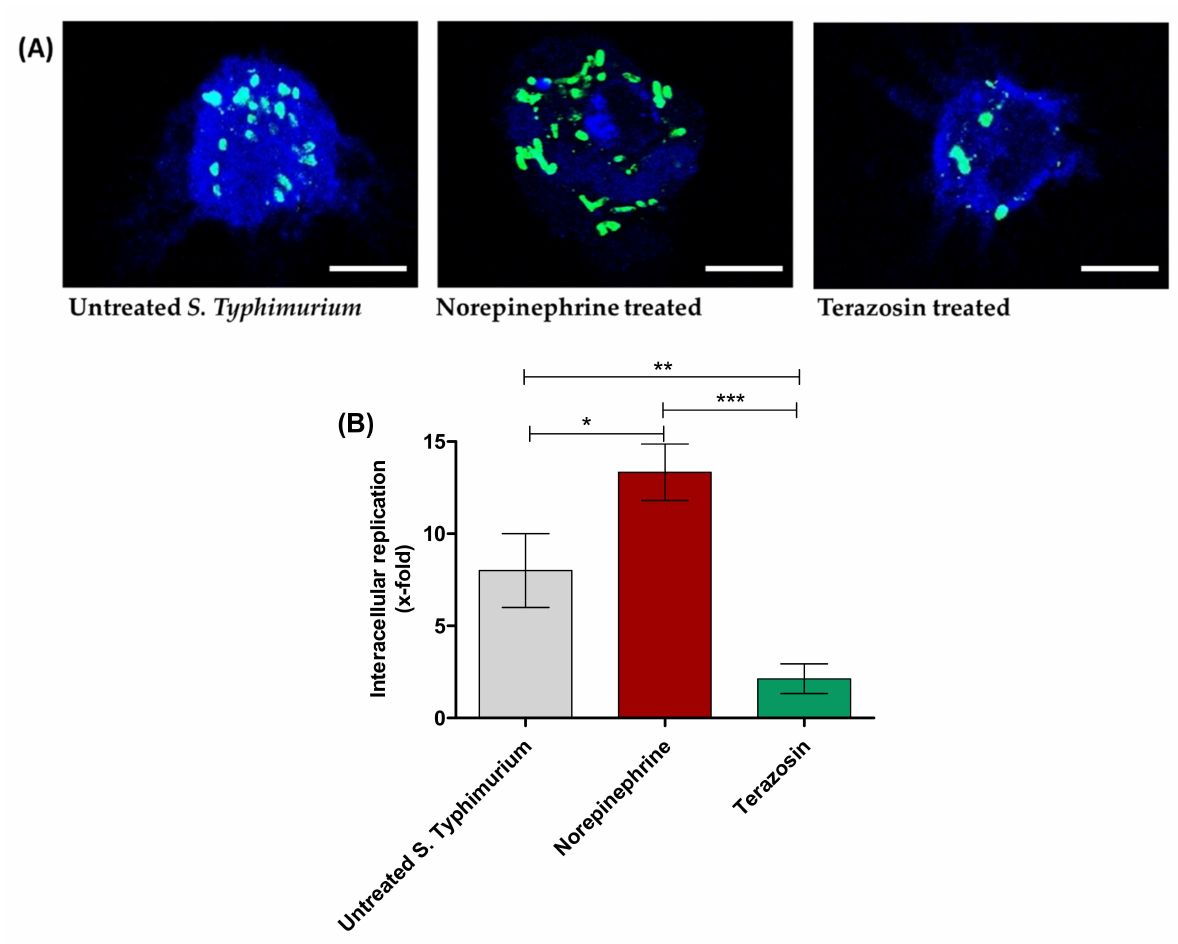
Figure 4. Terazosin diminishes S. Typhimurium intracellular replication in raw macrophage cells. ( A ) Microscopic images of S. Typhimurium in macrophages. Norepinephrine markedly increased the number of intracellularly replicating bacterial cells and terazosin at the sub-MIC diminished the bacterial intracellular replication in comparison to untreated S. Typhimurium. ( B ) The infected macrophages were lysed, and the phagocytosed cell/relative untaken cell percentage and x-fold intracellular replication were calculated. The experiment was repeated in triplicate, and the data are presented as the mean ± the SD. A one-way ANOVA test, followed by Tukey’s multiple comparison post-hoc test, was employed to attest the statistical significance; p < 0.05 was considered significant. *** = p < 0.0001; ** = p < 0.001; * = p < 0.05. Scale bars correspond to 100 µ